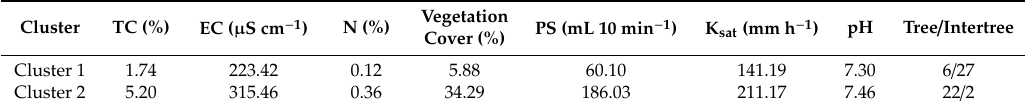
Table 6. Means of the inputs for the two-step cluster analysis in order of predictor influence. A tree / intertree column was separately added to indicate potential cluster predominance by tree or intertree